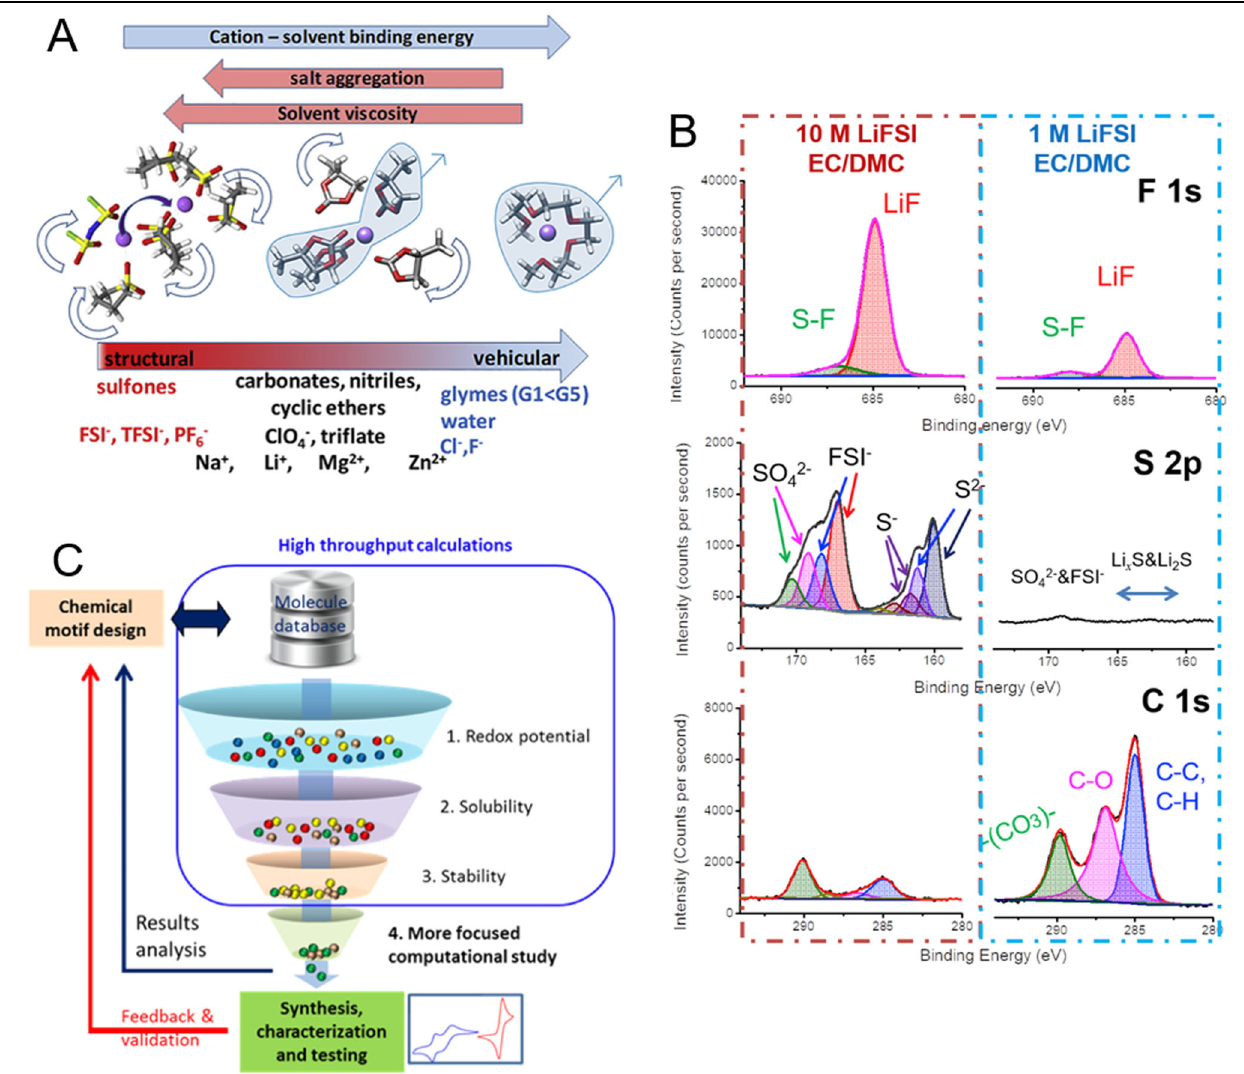
Fig. 2 | Aspects to consider for the development of highly-concentrated elec- trolyte solutions. A Parameters which in fl uence the contribution of the vehicular and structural diffusion transport mechanisms for metal cations in liquid electro- lytes (Reprinted from ref. 8 with permission from Elsevier.) B XPS analysis of Li metal cycled in concentrated (10M) and standard (1M) LiFSI in EC:DMC (1:1